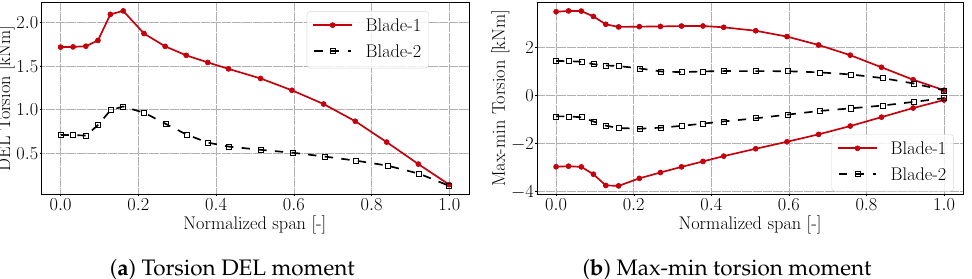
Figure 16. DEL and maximum—minimum torsion moment loads along the normalized blade span. Damage equivalent loads are computed for DLC1.2 load cases whereas maximum—minimum loads are from DLC1.3 load